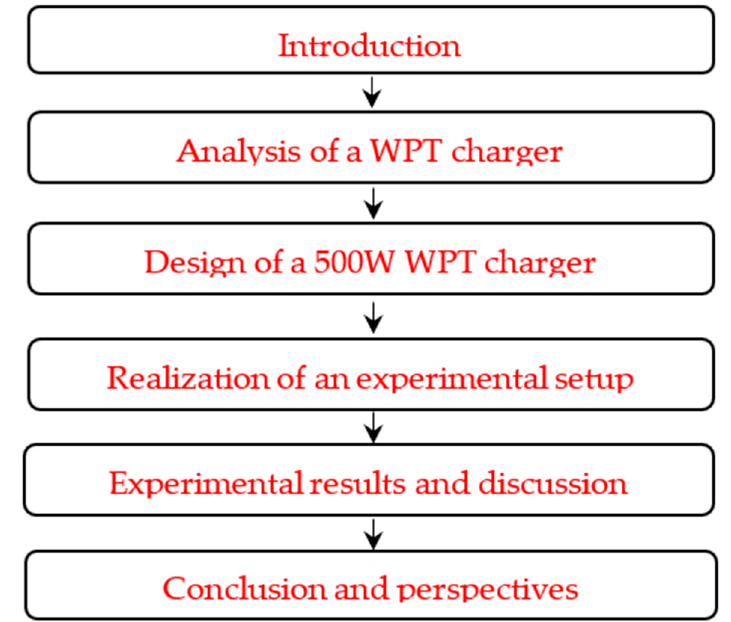
Figure 3. Flowchart of the organization of the paper.